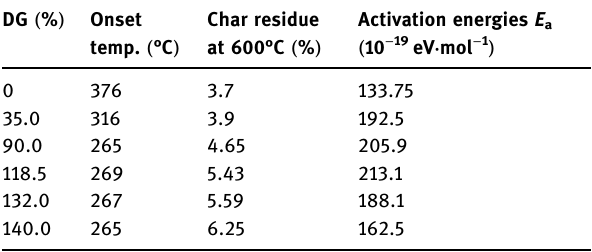
Table 3: The TGA and the energy of activation ( E a ) for the